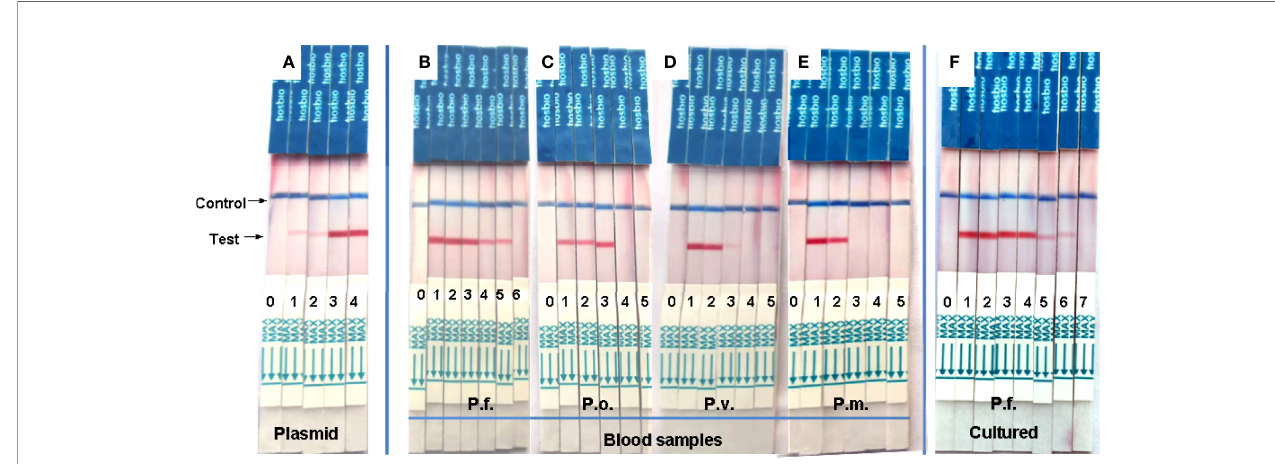
FIGURE 3 | Analytical sensitivity of RAA-LFD assay. (A) was a serial dilution the recombinant plasmid from10 3 to 10 0 copies/ m L. The sensitivity was 1 copies/ m L. 0- H 2 O, 1-10 0 copies/ m L, 2-10 1 copies/ m L, 3-10 2 copies/ m L, 4-10 3 copies/ m L. (B – E) were gradient dilution of genomic DNA from P. faciparlum (P.f., 0.1pg/ m L), P. oval (P.o., 10 pg/ m L), P. vivax (P.v., 10-100 pg/ m L) and P. malariae (P.m., 100pg/ m L) DNA from 200 m L whole blood, respectively. 0-H 2 O, 1-10 3 pg/ m L, 2-10 2 pg/ m L, 3-10 pg/ m L, 4-1pg/ m L, 5-10 -1 pg/ m L, 6-10 -2 pg/ m L. (F) was the parasite density of cultured P. faciparlum (P.f.) and the sensitivity was 0.5 parasites/ m L. 0-H 2 O, 1-10 4 parasites/ m L, 2-10 3 parasites/ m L, 3-10 2 parasites/ m L, 4-10 parasites/ m L, 5-1 parasite/ m L, 6-0.5 parasite/ m L, 7-0.25 parasite/ m